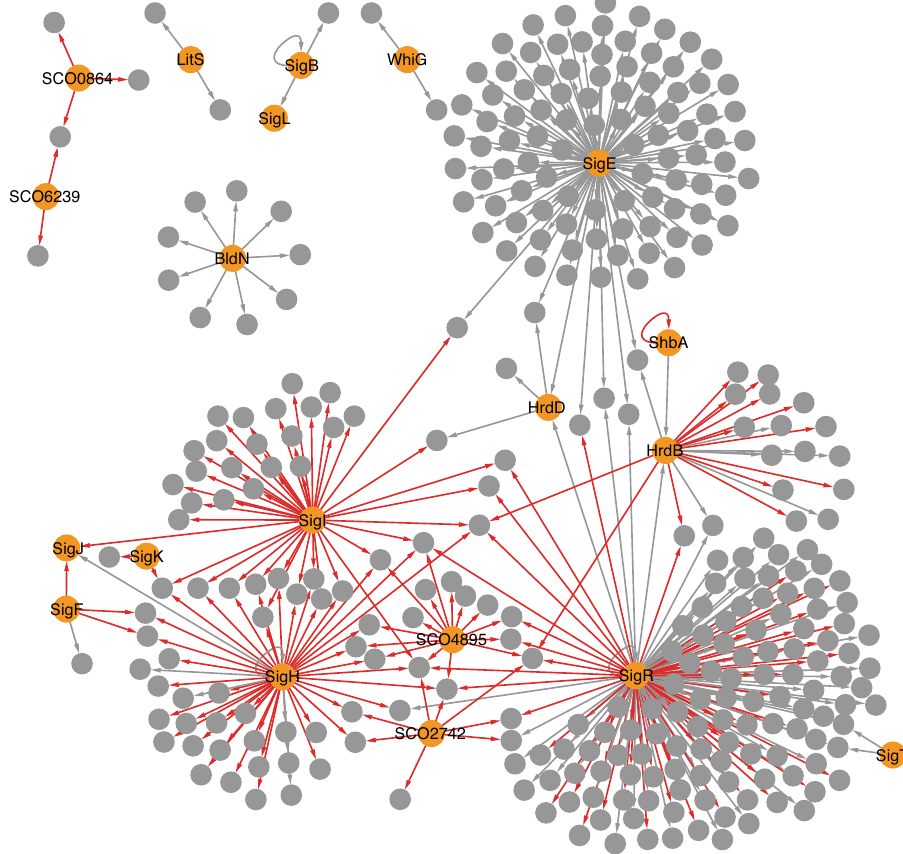
Fig. 4 Transcriptional regulatory network controlled by sigma factors. Orange nodes indicate sigma factors and grey nodes indicate other genes. Grey arrows are previously known regulation and red arrows are regulation identi fi ed by RIViT-seq in this